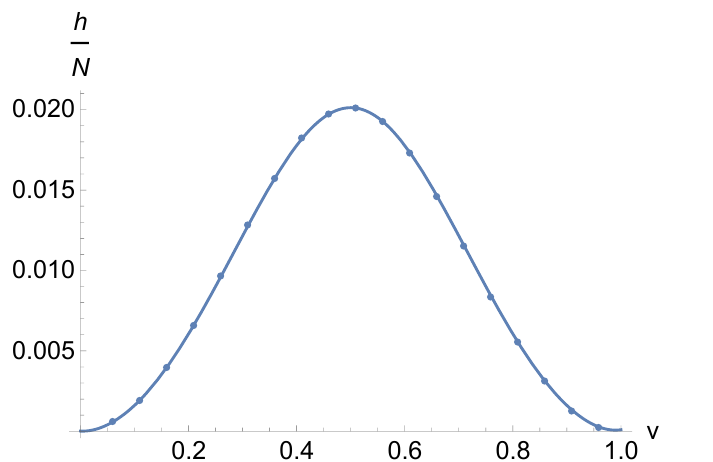
Figure 8. Numerical result and a smooth interpolation for conformal weight in d = 3